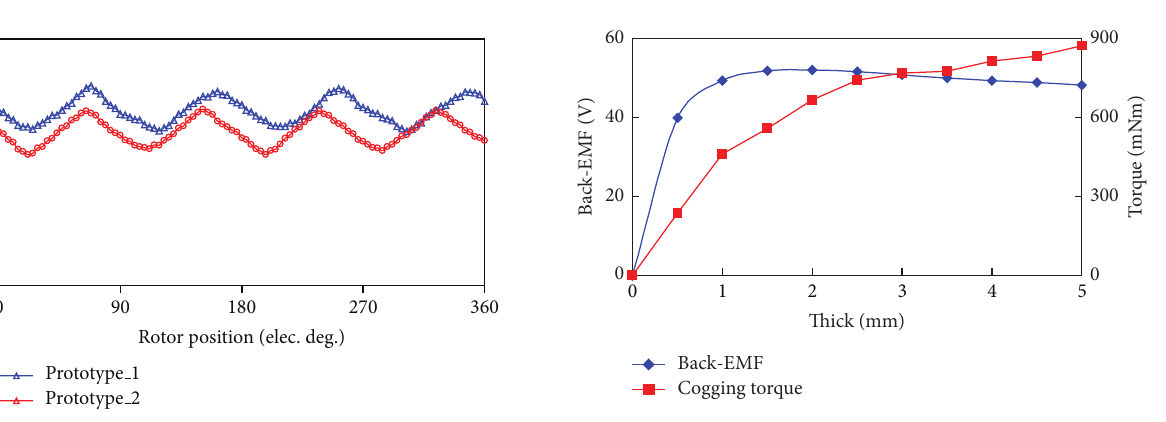
Figure 7: Peak value variations of back-EMF and cogging torque with PM radial thickness 𝐻 pm